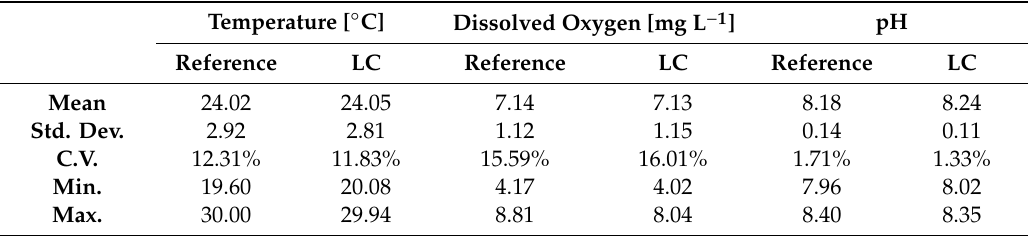
Table 1. Comparison of reads of water-quality parameters between the low-cost (LC) proposed system and reference